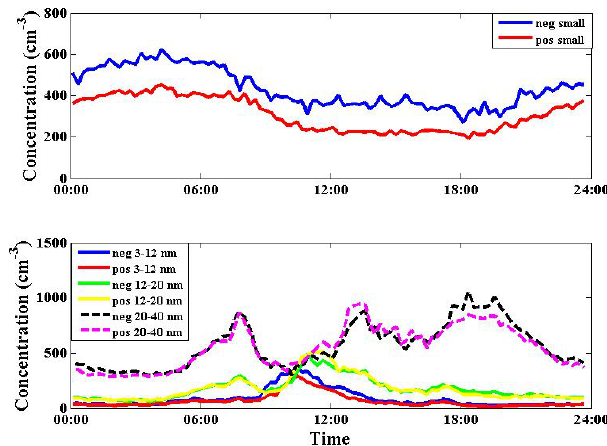
Fig. 6. Median diurnal concentrations: small ion concentrations are shown in the upper panel and concentrations of nucleation mode and 20–40nm ions are presented in the lower